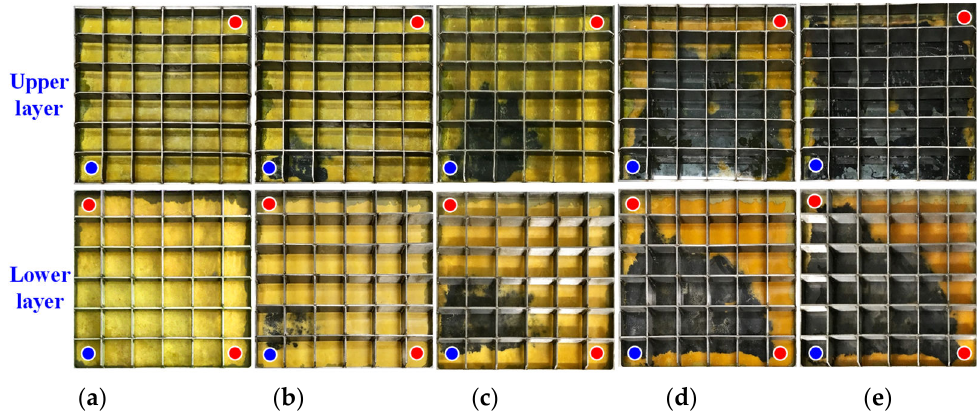
Figure 6. Sweeping field map of Experimental Program 1; ( a ) Images of the upper and lower layers at hour 0; ( b ) images of the upper and lower layers at hour 3; ( c ) images of the upper and lower layers at hour 6; ( d ) images of the upper and lower layers at hour 12; ( e ) images of the upper and lower layers at hour 18.